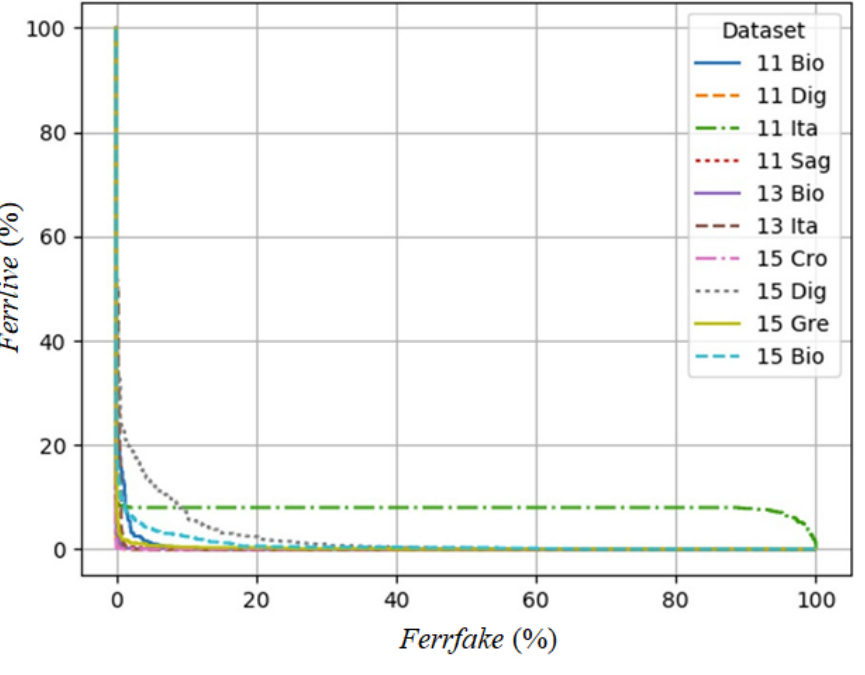
Figure 9. Detection Error Trade-off (DET) graph of fPADnet with error range from zero to 100%.